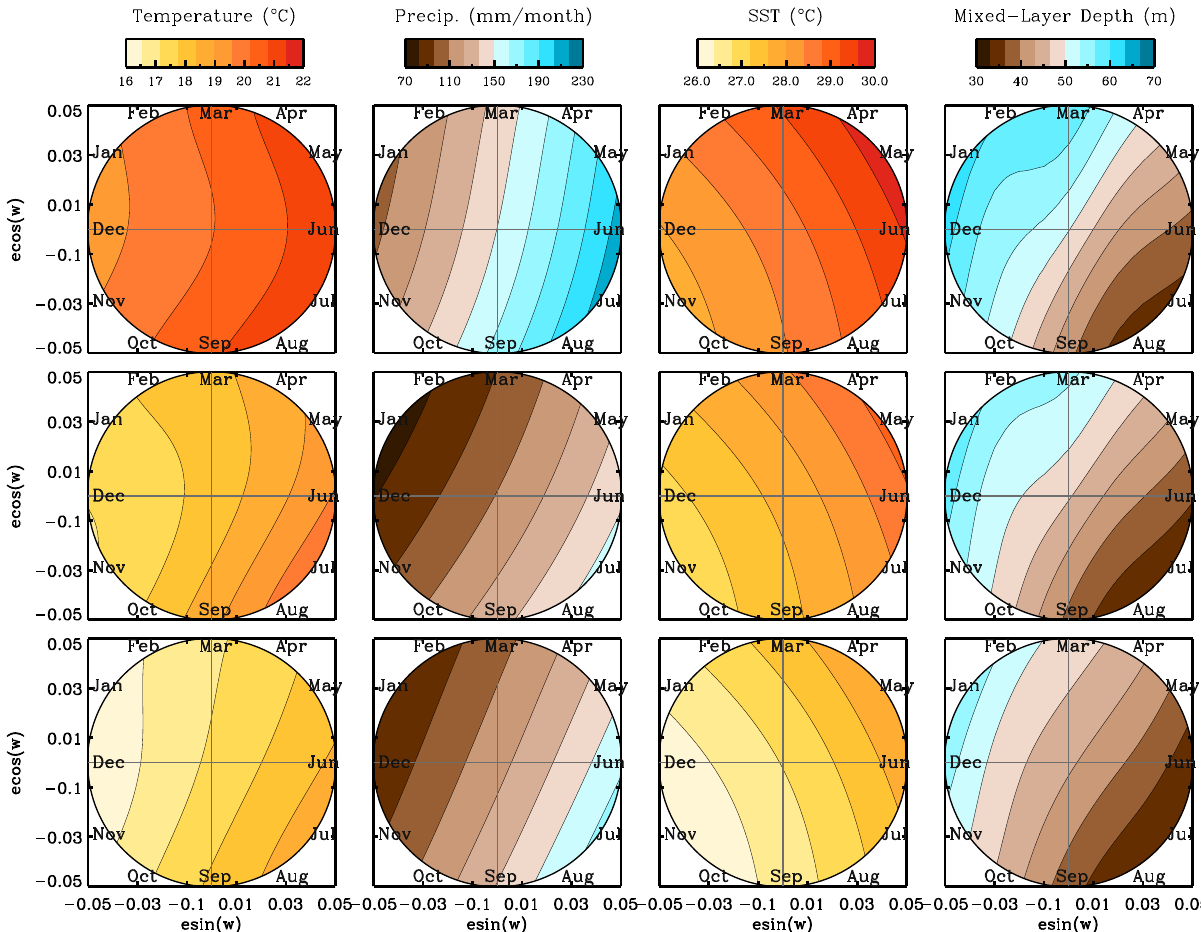
Figure 10. Sensitivity to e cos ((cid:36)) and e sin ((cid:36)) for all fields. Each panel, from top to bottom, shows the four fields with a different config- uration of glaciation level – CO 2 concentration. Top panels: glaciation level = 1 and CO 2 = 280ppmv. Middle panels: glaciation level = 5 and CO 2 = 230. Bottom panels: glaciation level = 11 and CO 2 = 180. All fields were integrated over obliquity.